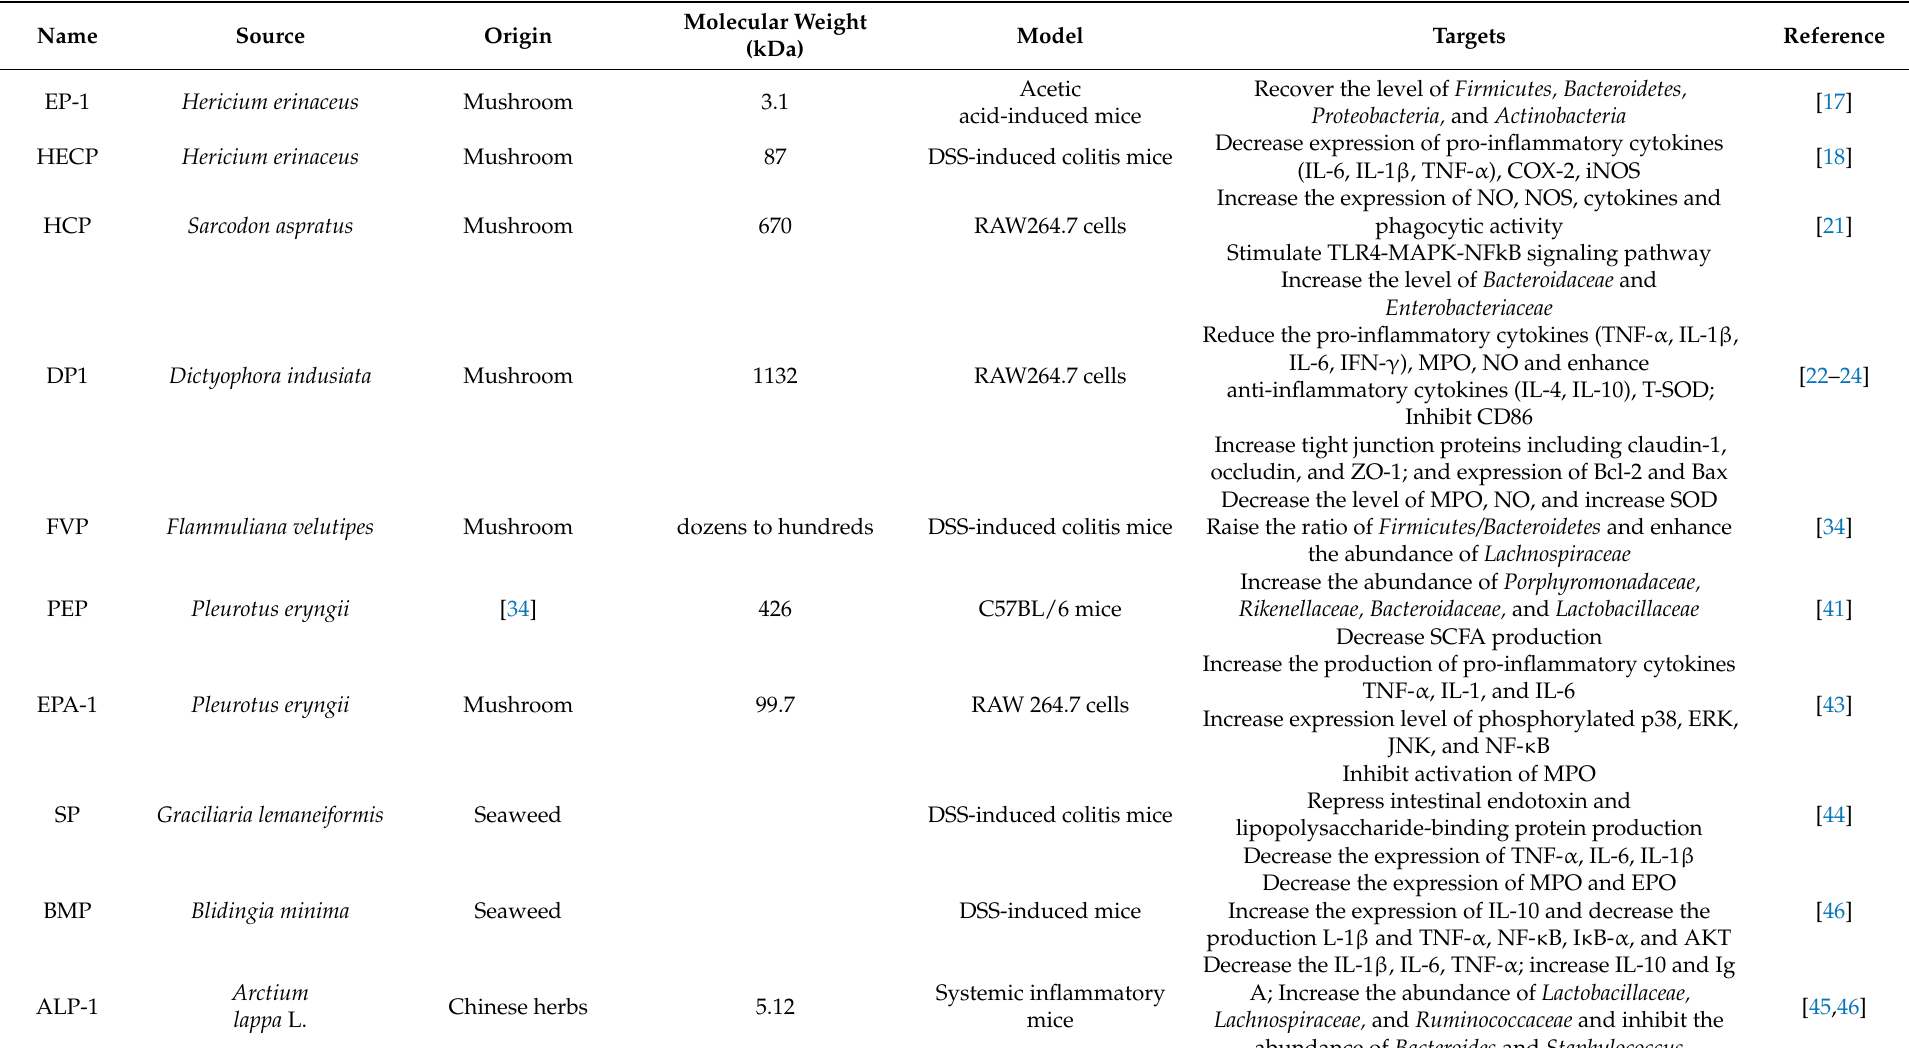
Table 1. Summary of the effects of some natural polysaccharides on inflammatory bowel disease